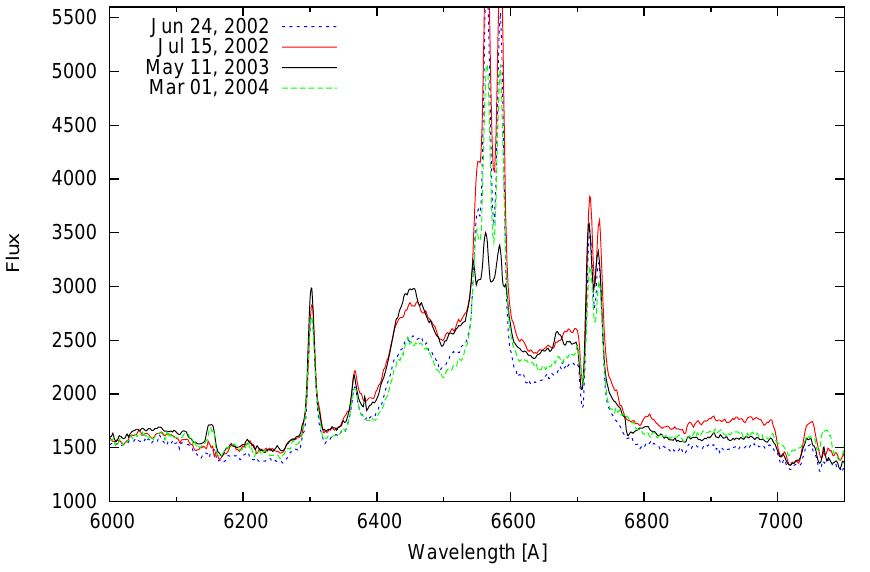
Fig. 2. Flux variability of Arp 102B. Dates are given in the